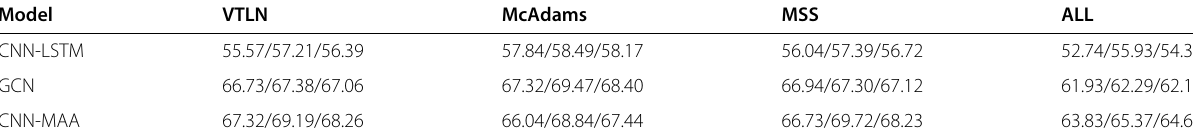
Table 6 Performance of the three models under the Modulation Spectrum Smoothing attack ( UA / WA / ACC )